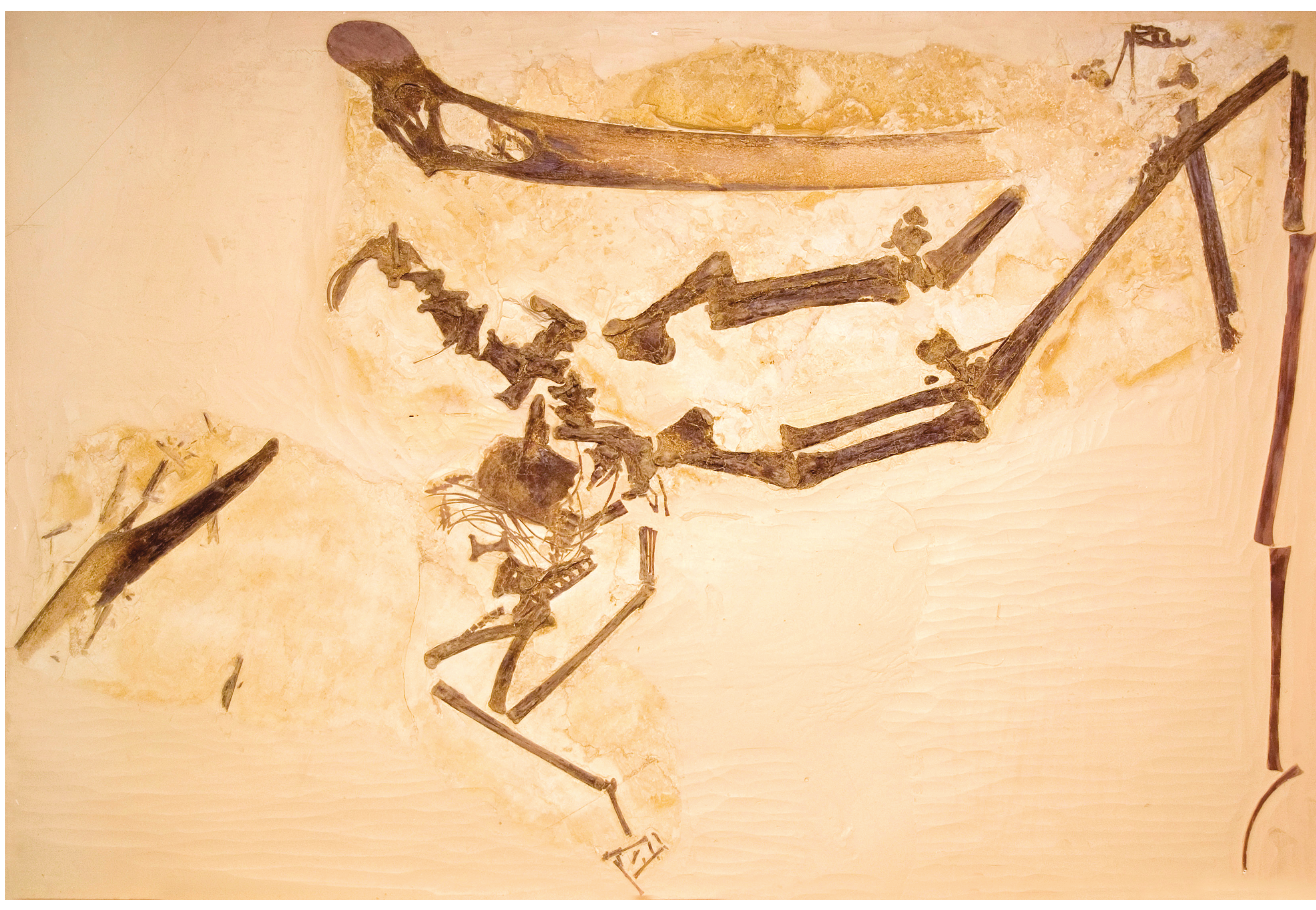
Figure 1. Photograph of UALVP 24238. Cranial crest and wing phalanges 2-4 of the left wing have been reconstructed with plaster and paint (on the right side of the photograph), as well as metatarsals of the left